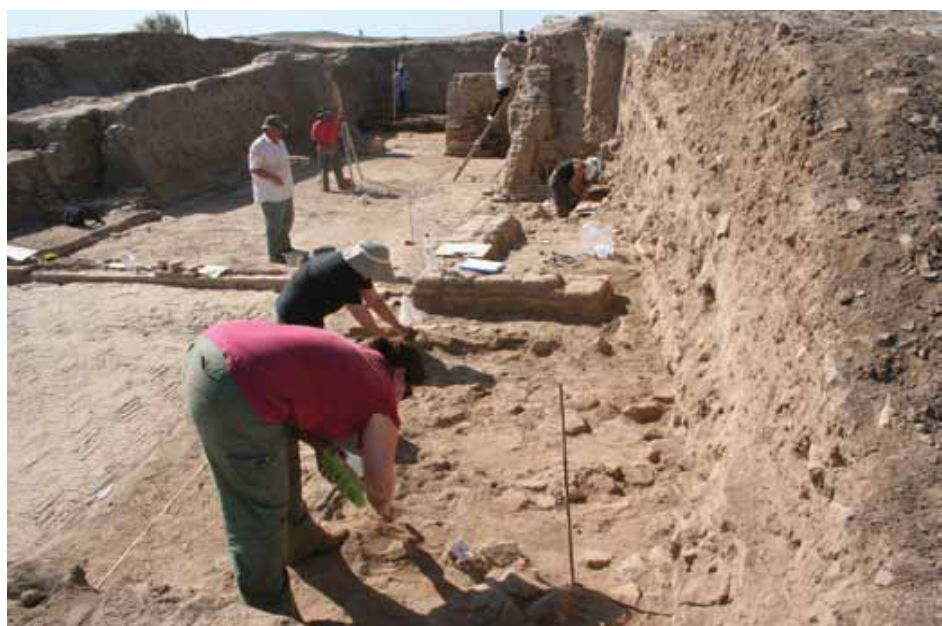
Fig. 2: Excavation of one of the central markets of the Islamic city in 2010. The walls of the buildings (in the background), destroyed in the Mongol sack of the city, still stand c.2.5m high, to just below the contemporary ground surface, with the floors and her- ringbone brick courtyard preserved under the destruction debris and erosion